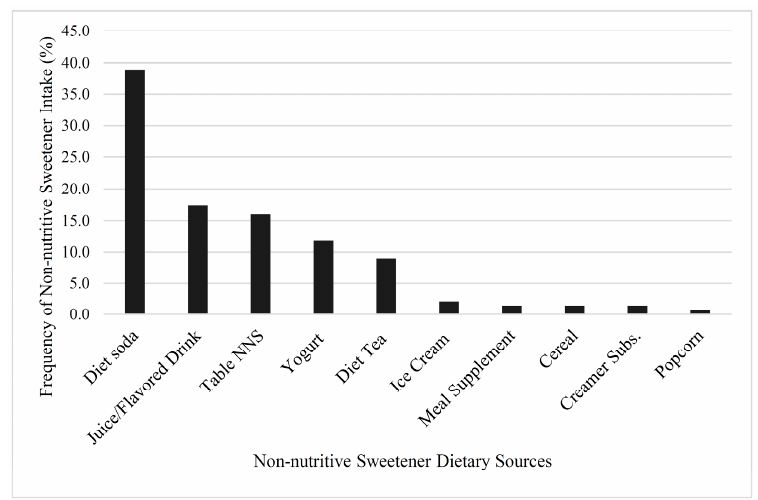
Figure 1. Dietary sources of non-nutritive sweetener (NNS) shown as percentage of total occurrences of NNS intake ( n = 144) among NNS consumers ( n = 100).